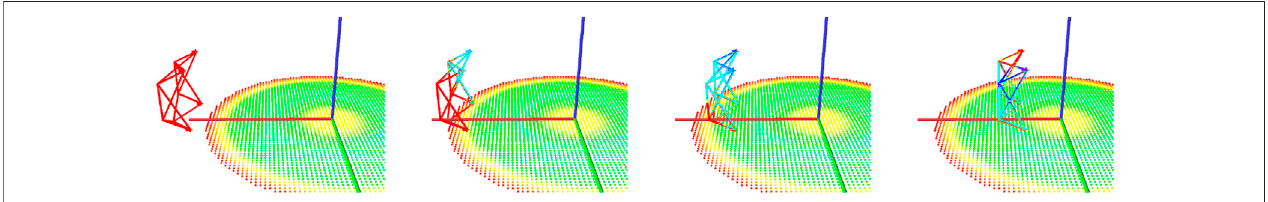
FIGURE 14 | Grasp selection for fail-safe spacecraft docking. The fi gure depicts only the bar structure used for grasping (the structure mounted on the client satellite is shown in Figure 13 ), and shows how the grasp possibilities change depending on the target location with respect to the servicer. The color of the structure corresponds to the v i , p value; blue areas are preferred for grasping. The grasp pose selected must lie in a region with high v i , p across all the maneuver sequence.